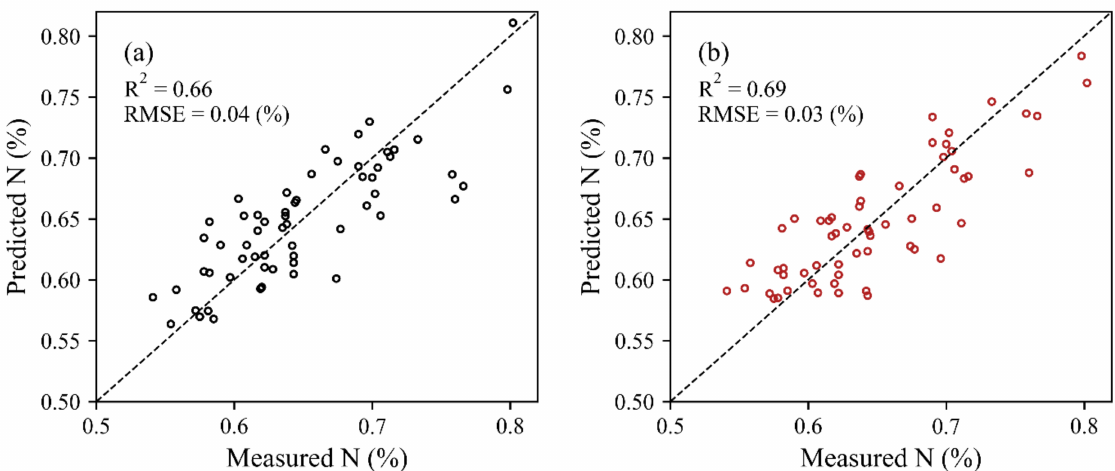
Figure 7. Relationships between the measured and estimated N concentration at the leaf-level for the ( a ) HSL and ( b ) ASD datasets. The estimated values were obtained using the PLSR